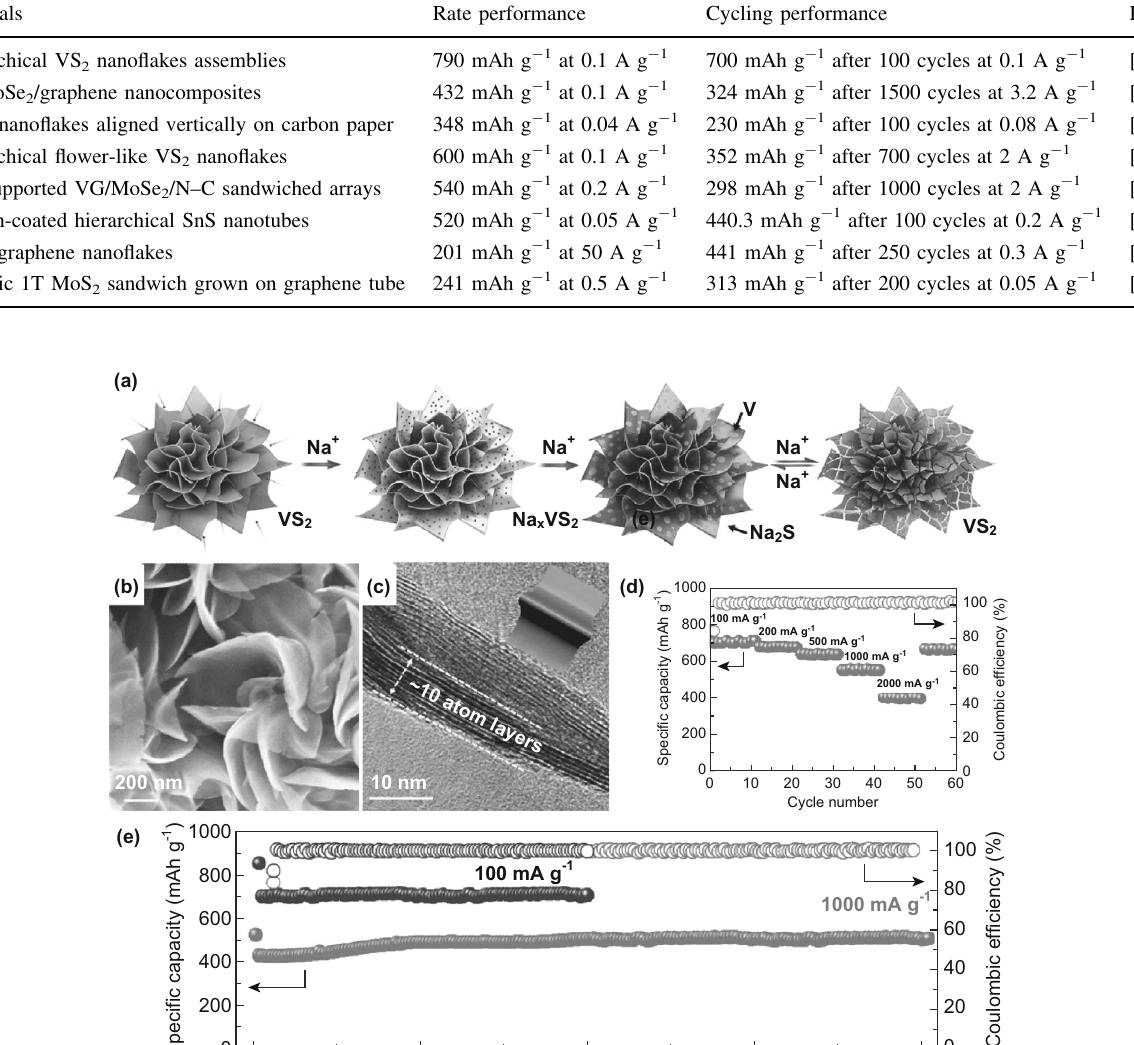
Table 3 Comparison of electrochemical performance of 2D nanoflake ensemble-based materials for sodium-ion batteries Materials